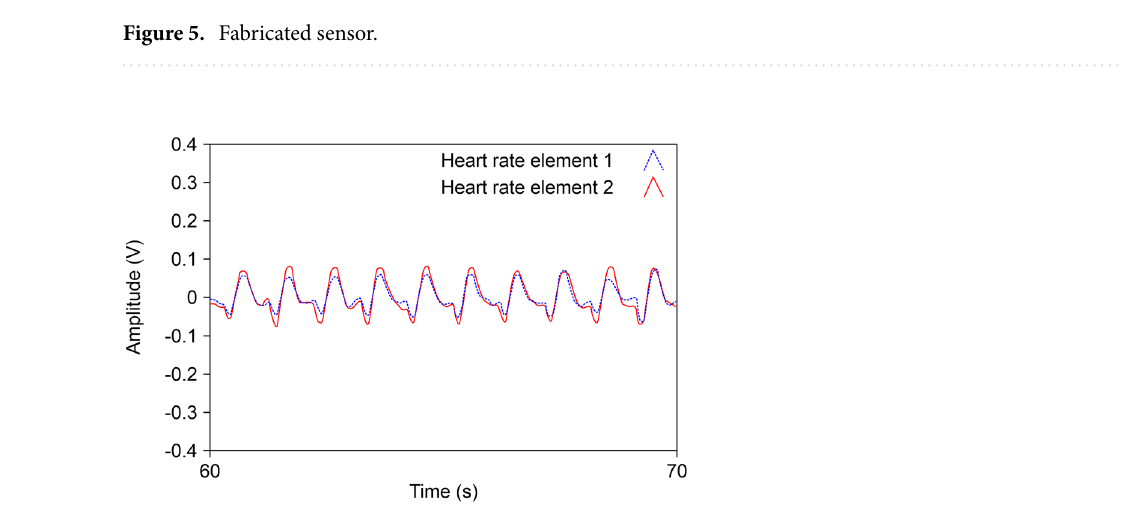
Figure 6. Results of filtering wrist